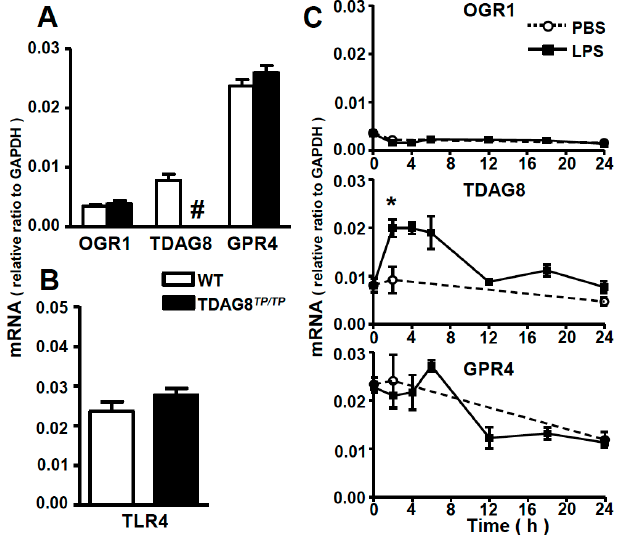
Figure 1. TDAG8 mRNA expression is enhanced by LPS treatment. The mRNA expressions of proton-sensing GPCRs in ( A ) and TLR4 in ( B ) in lung tissues of WT and TDAG8 TP/TP mice were measured. # The expression of TDAG8 is undetectable; ( C ) The time course change in mRNA expression of proton-sensing GPCRs in lung tissues after PBS or LPS instillation. Results are expressed as a ratio relative to GAPDH. Data are mean ± SEM of n = 3–5 for each group. The effect of LPS is significant, * p < 0.05 (PBS vs. LPS).